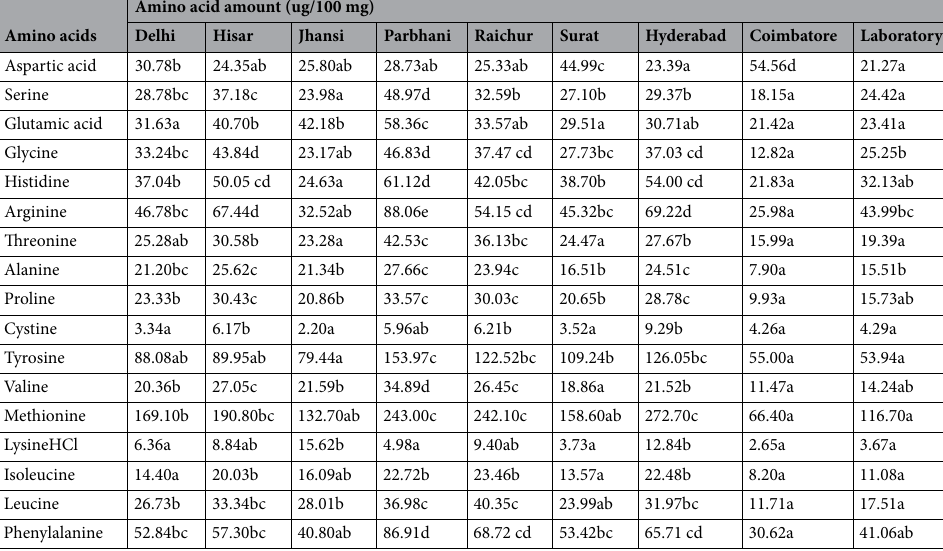
Table 4. Amino acid amount in Chilo partellus larvae from different geographical regions of India. The values in a row following different letters are significant at P = 0.05 using post-hoc Tukey’s HSD test.